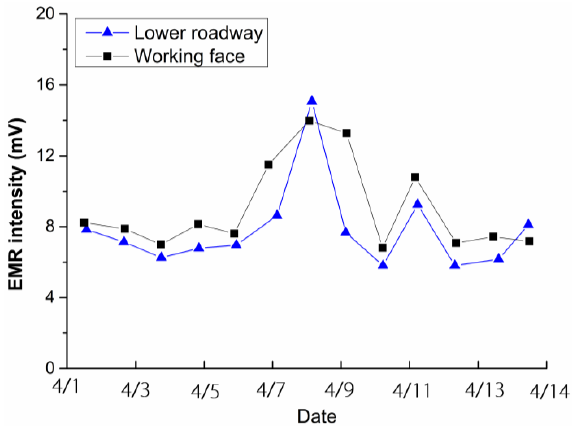
Figure 18. The change of EMR signals at the working face and lower roadway.